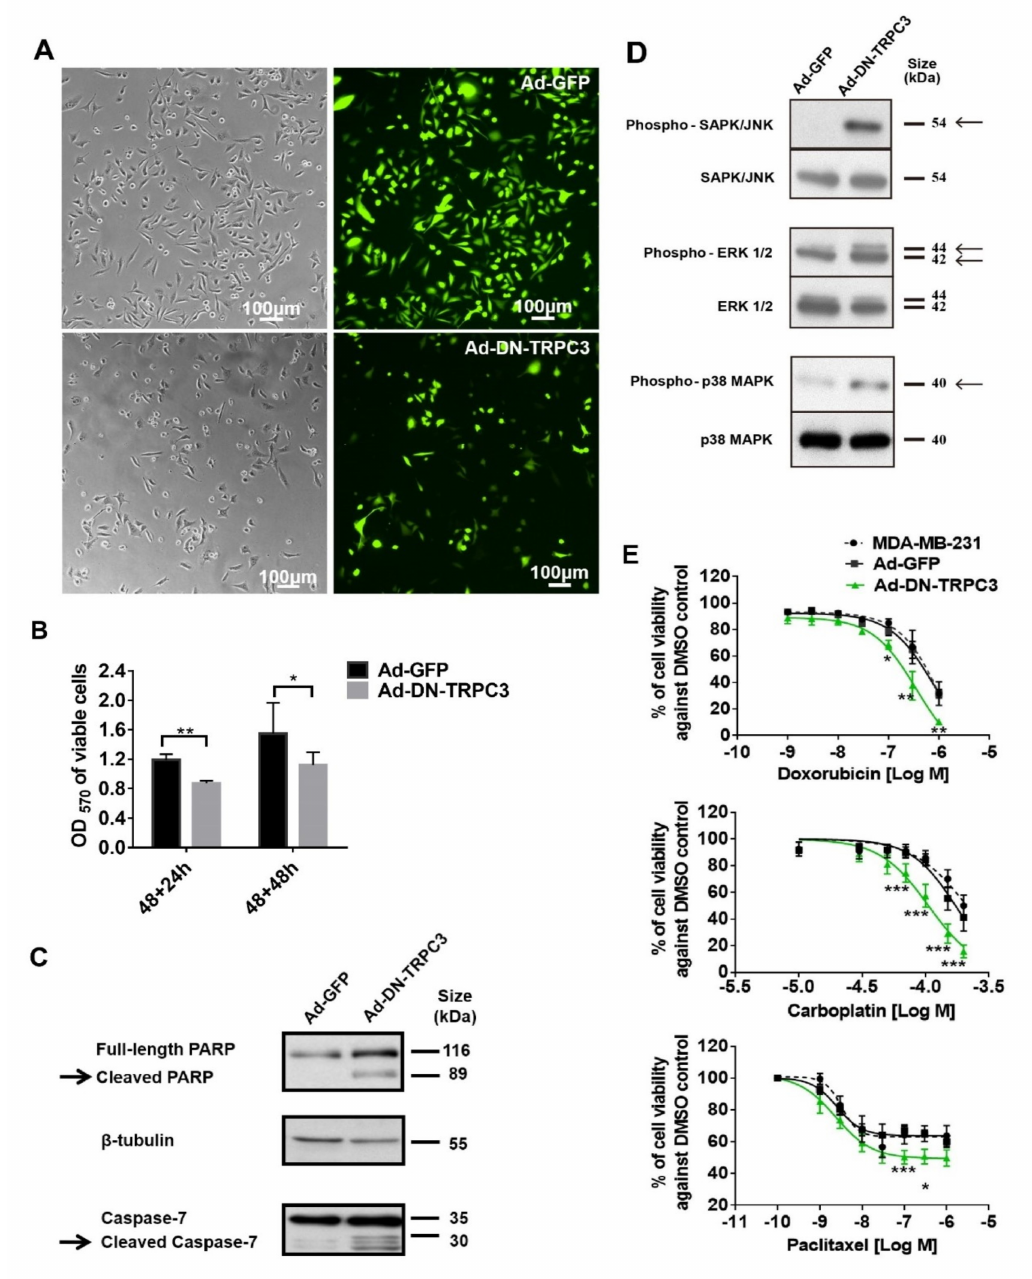
Figure 3. Dominant negative (DN) of TRPC3 attenuated proliferation, induced apoptosis and sensitized cell death to chemotherapeutic agents in MDA-MB-231. ( A ) recombinant adenoviruses (Ad) harboring GFP (Ad-GFP) or DN of TRPC3 (Ad-DN-TRPC3) were used to infect MDA-MB-231 for 48 h. Infection e ffi ciency was determined by the percentage of cells with GFP fluorescence and was typically assessed to be 90–95%; ( B ) DN of TRPC3 attenuated cell proliferation as measured by MTT assay performed at 24 and 48 h after adenoviruses withdrawal. OD570 values of viable cells were compared between Ad-GFP and Ad-DN-TRPC3-infected group at di ff erent time points. Values are mean ± SEM ( n = 3). * p < 0.05, ** p < 0.01; ( C , D ) representative Western blots showing that DN of TRPC3 ( C ) induced apoptosis in a caspase-dependent manner and ( D ) activated MAPK pathways in MDA-MB-231 cells. Similar results were obtained when the cells were incubated with Pyr3 (cf. Figure 2); ( E ) DN of TRPC3 sensitized cell death to chemotherapeutic agents in a concentration-dependent manner as measured by MTT assay. Ad-GFP-infected cells and non-stimulated MDA-MB-231 cells presented similar trends of decrease in cell viability in response to doxorubicin, carboplatin or paclitaxel. Values are mean ± SEM ( n = 3). * p < 0.05, ** p < 0.01 and *** p < 0.001 versus Ad-GFP